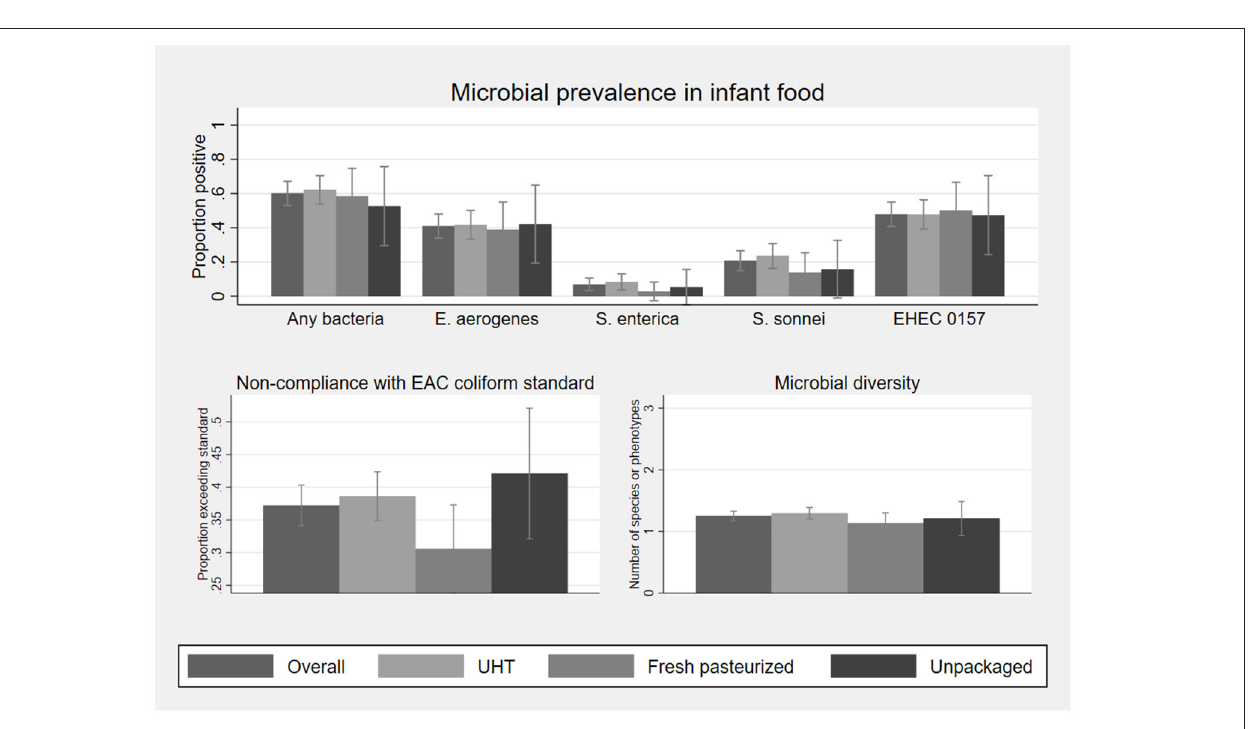
Frontiers in Public Health |